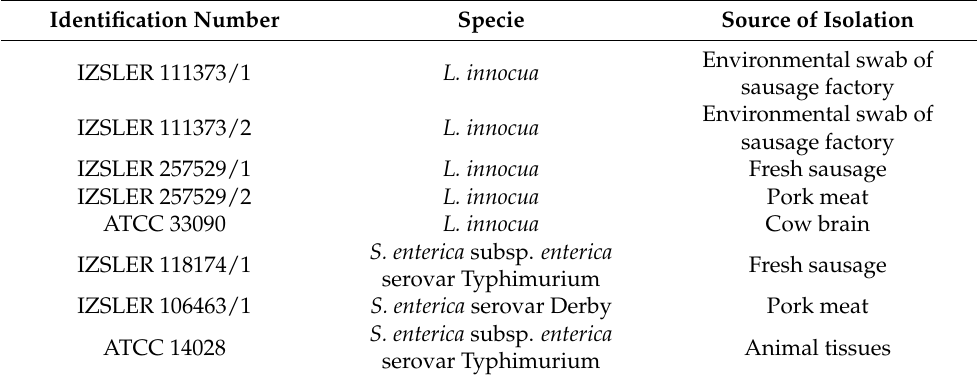
Table 1. Strains used for inoculation of L. innocua and Salmonella